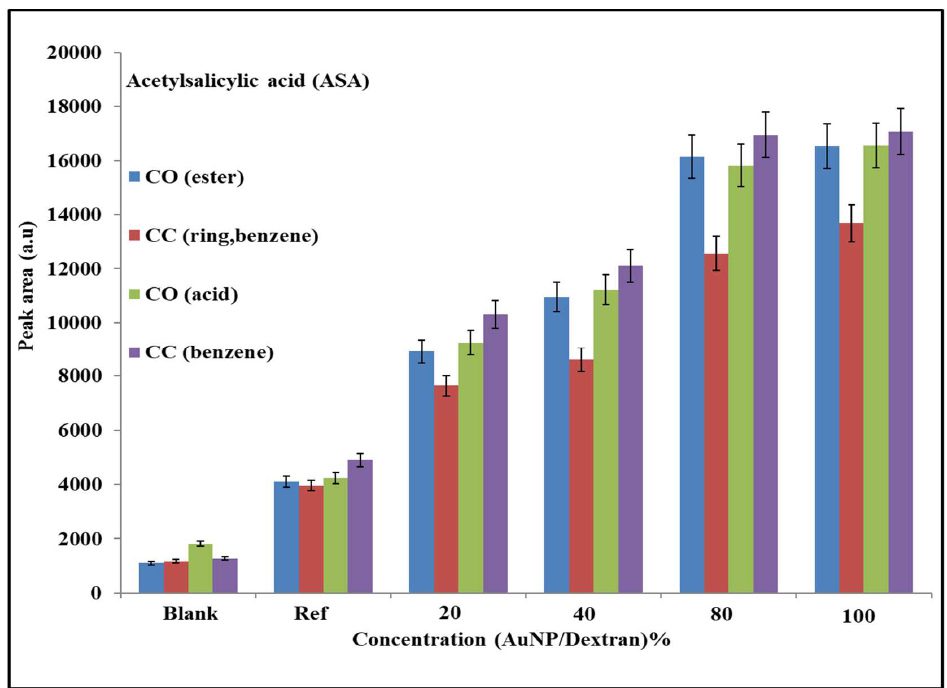
Figure 5. Histogram of ASA functional groups. The plot shows a peak area (PA) vs. Au/dextran NP concentration. The blank sample is 5% dextran, while the reference is 10% ASA in 5% Au/dextran NP solution; 5% error bars are shown for each analysis.